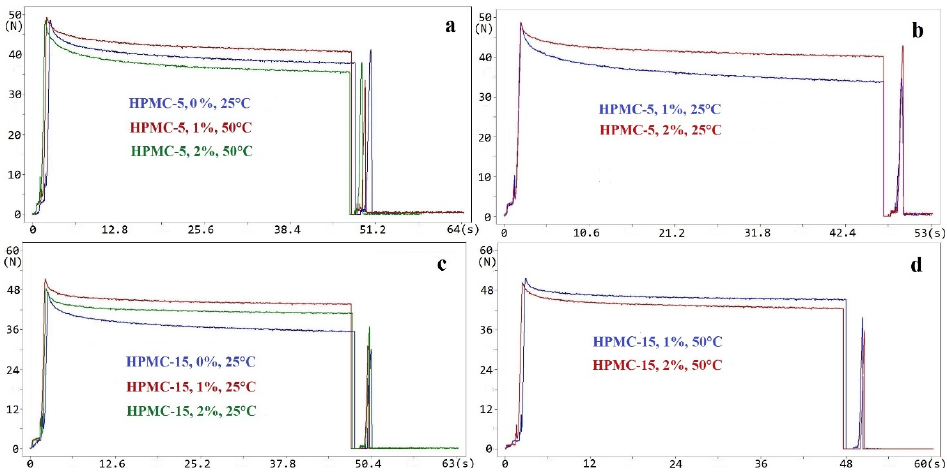
Figure 3. In vitro mucoadhesive force of HPMC and HPMC containing SE films. ( a ) HPMC-5, 50 °C; ( b ) HPMC-5, 25 °C; ( c ) HPMC-15, 25 °C; ( d ) HPMC-15, 50 °C.